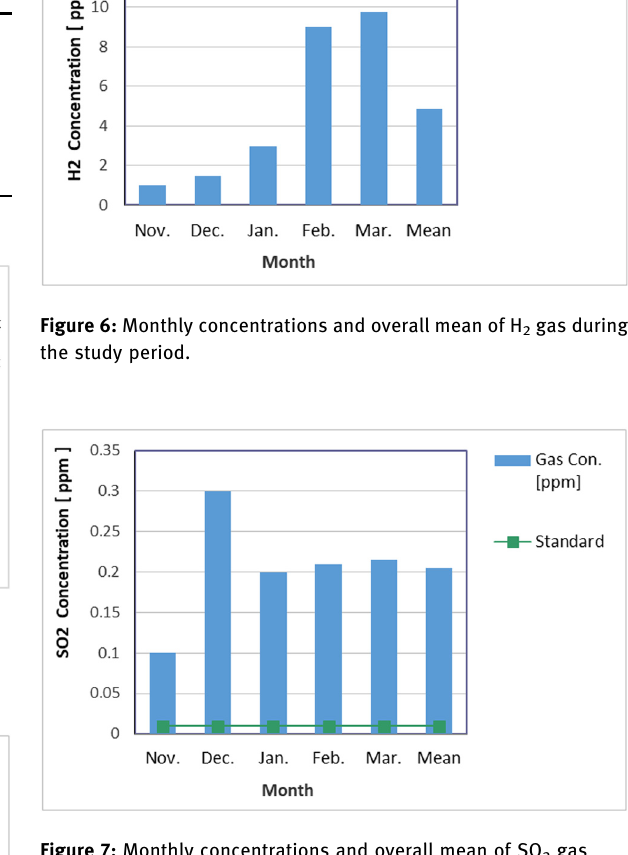
Table 2: The statistical summary of measured gases Gases